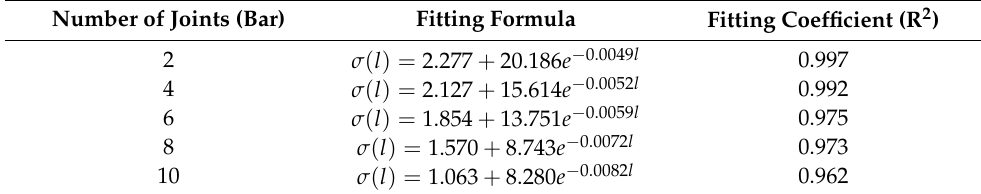
Table 9. Fitting relationship between UCS and rock size.